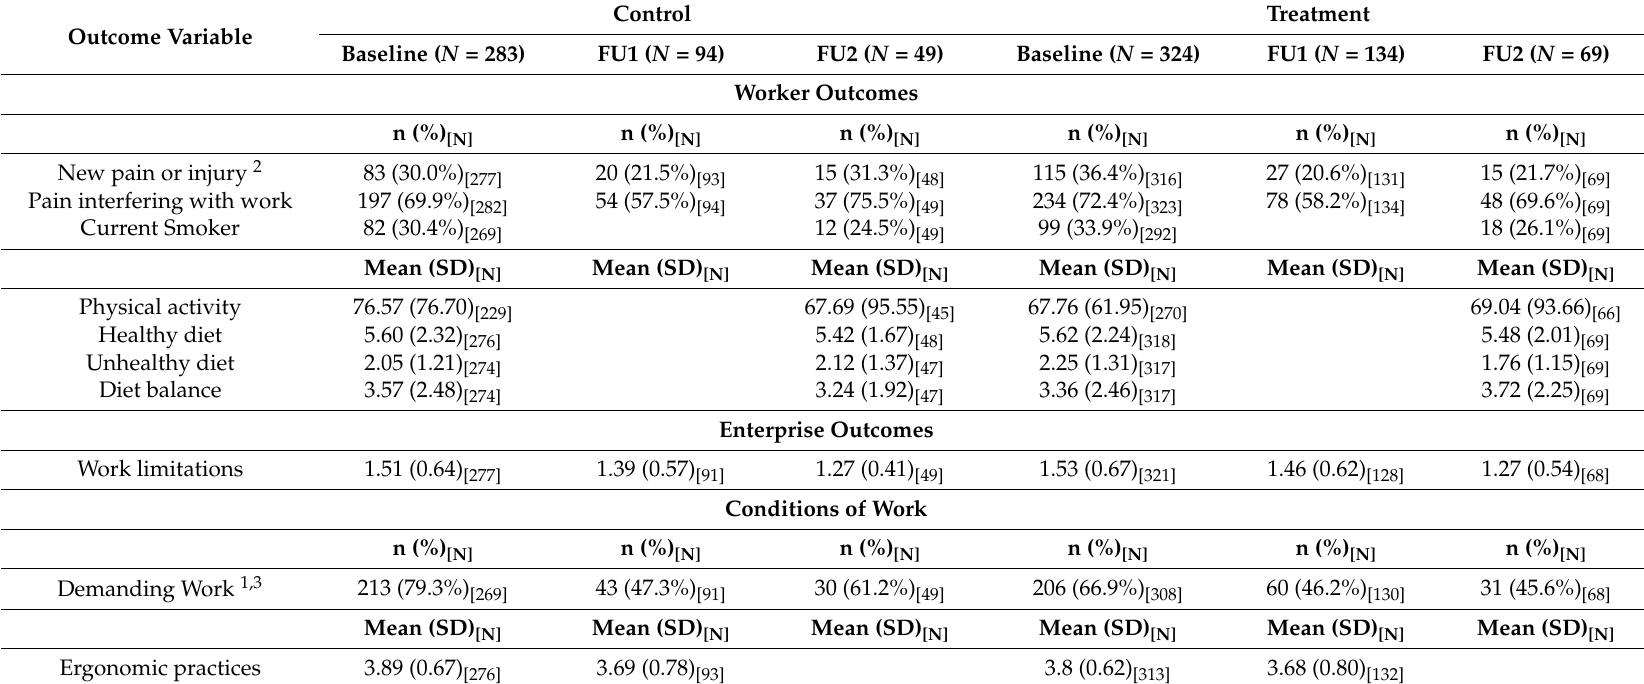
Table 2. Descriptive statistics for primary and secondary outcome